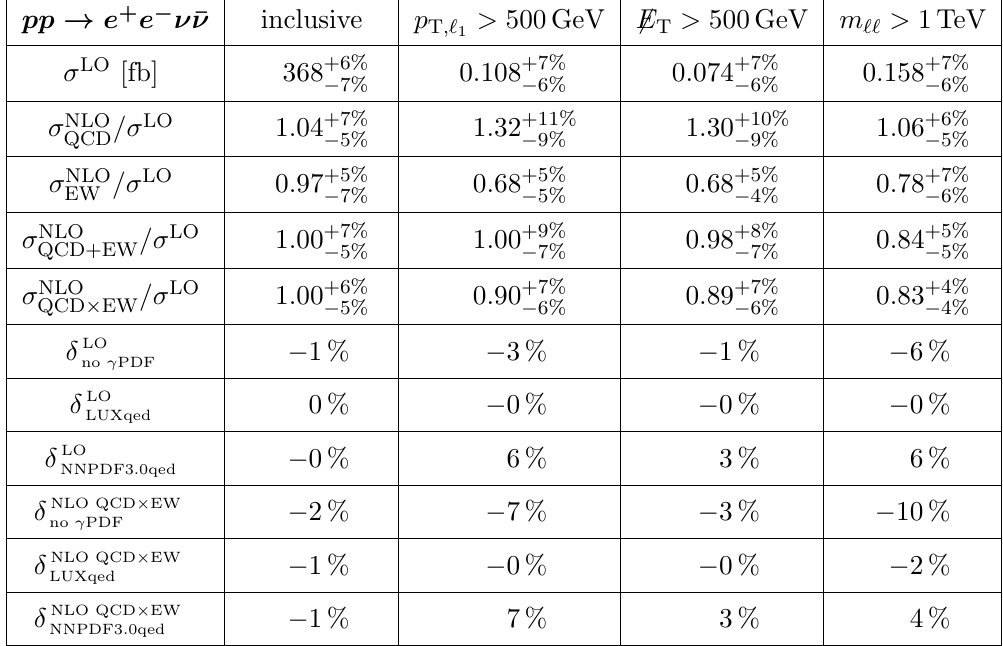
Table 6 . Cross-sections for pp e + e (cid:0) (cid:23) (cid:22) (cid:23) at 13 TeV including all neutrino (cid:13)avours. Higher-order ! corrections, scale uncertainties and photon-induced contributions are presented as in table 5.